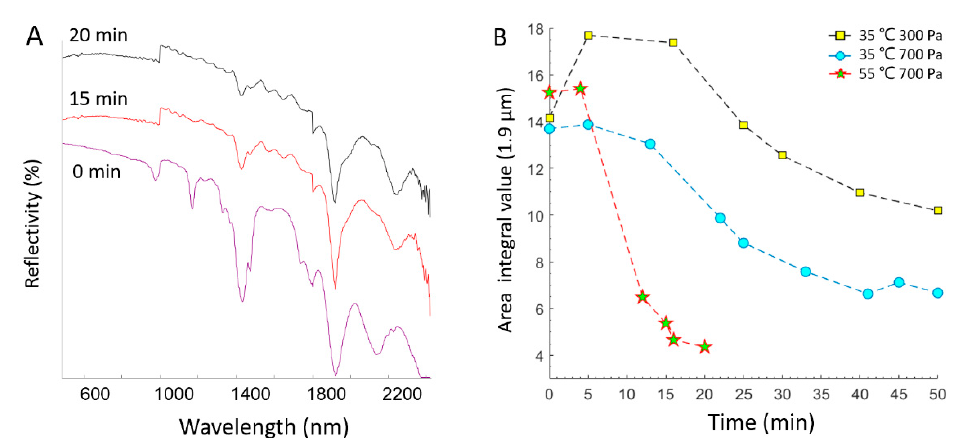
Figure 4. ( A ) Spectra of NaClO 4 .H 2 O during continuous monitoring in the Mars environment chamber (MEC) at 35 °C and 700 Pa. ( B ) The decrease in the absorption band area near 1.9 μ m of NaClO 4 .H 2 O as a function of time in the MEC at different temperatures (35 °C, 55 °C) and gas pressures (300 Pa, 700 Pa).